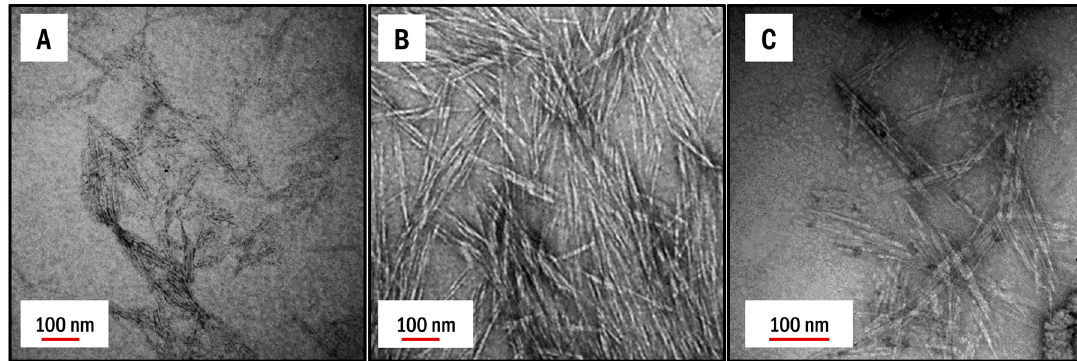
Figure 4. Transmission electron microscopy (TEM) images of as received CNCs: ( a ) Forest Products Laboratory (FPL), ( b ) Celluforce (CF), and ( c ) GranBio BioPlus (BP).